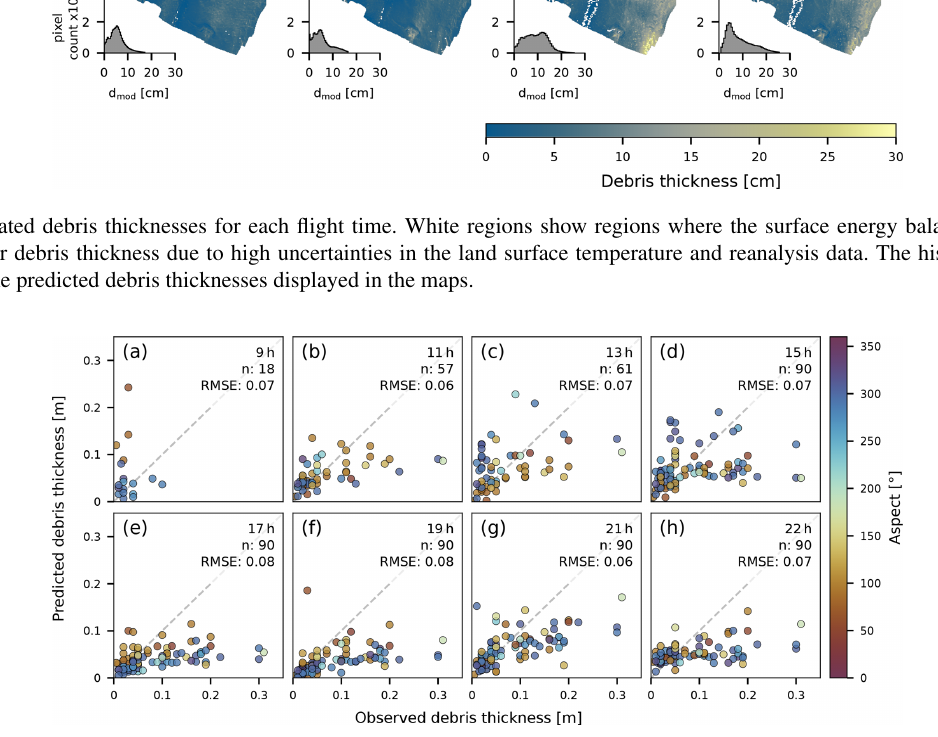
Figure 8. Comparison of modeled and observed debris thickness for each flight time (a–h) with RMSE values (m) for model evaluation. Sample points are colorized by terrain aspect and the dashed grey line shows the 1 : 1 line. RMSE for flights (a, b, c) is based on a reduced sample